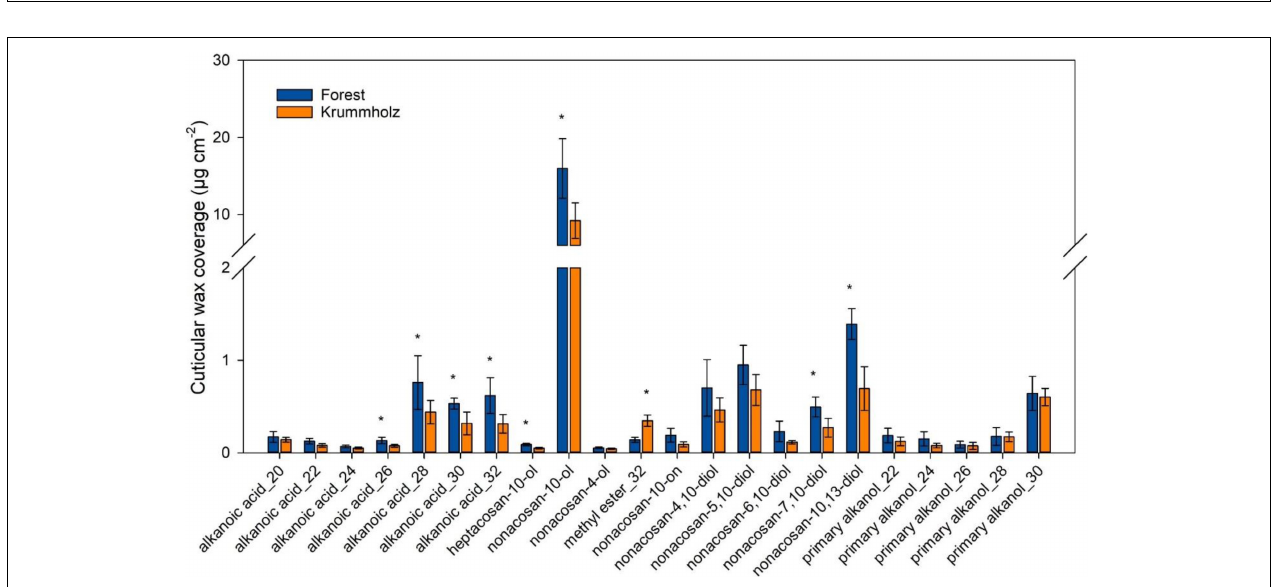
FIGURE 6 | Contribution of single compounds to the cuticular wax coverage of P. uncinata needles grown at Forest and Krummholz populations ( n = 5; mean ± standard deviation). Asterisks indicate statistically significant differences ( p < 0.05) between both populations.